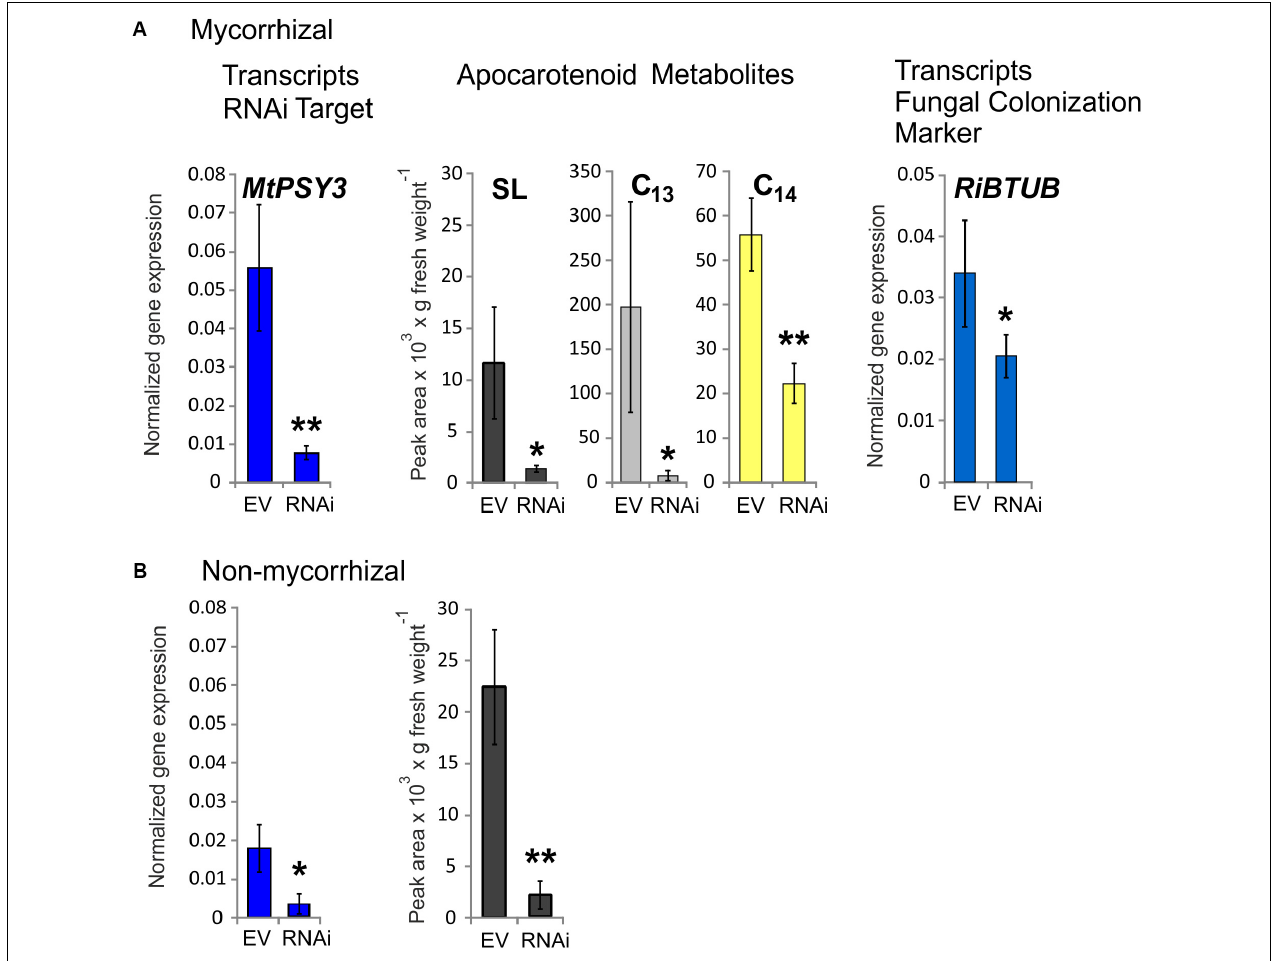
FIGURE 5 | Knockdown by RNAi of MtPSY3 expression in transgenic hairy roots of M. truncatula affecting apocarotenoid levels and fungal root colonization. (A) Transgenic roots of mycorrhizal empty vector (EV) control plants compared to MtPSY3 -RNAi-suppressed transgenic roots. EV and RNAi, n = 3 each. (B) Transgenic roots of non-mycorrhizal EV and MtPSY 3-RNAi suppressed plants. EV, n = 3 + one unsuppressed RNAi plant; RNAi, n = 2. All plants were cultivated with 20% Pi supply. Root fractions were analyzed for MtPSY3 transcript levels by qRT-PCR (left panels, blue columns). In mycorrhizal samples, a fungal marker gene for root colonization ( RiBTUB ) was included in the analysis (right panel in A ). Data were normalized to constitutively expressed MtEF1 α . In additional fractions various root apocarotenoid derivatives (SL, C 13 α -ionols and C 14 mycorradicin as indicated) were quantified from mycorrhizal roots and SL was determined also from non-mycorrhizal roots (center panels in A or right panel in B ). Mean values ± SD are shown. RNAi data were compared with EV controls by Student’s t -test ( ∗ p ≤ 0.05, ∗∗ p ≤